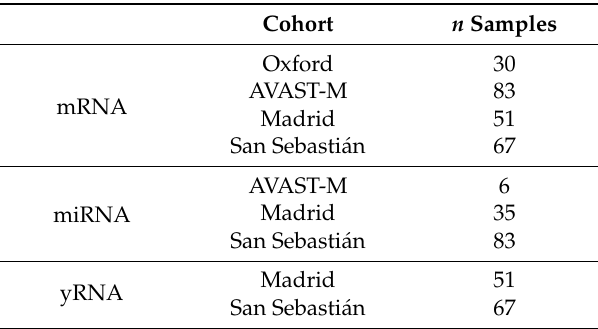
Table 5. Details of origin of patient cohorts used in